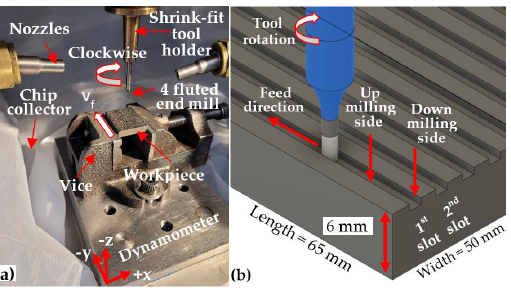
Figure 3. ( a ) Experimental setup and ( b ) schematic of the slot-milling operation.